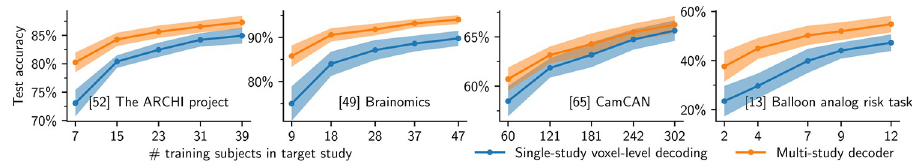
Fig 3. Varying accuracy improvement with study size. Training an MSTON decoder increases decoding accuracy for many studies (see Fig 2A). Gains are higher as we reduce the number of training subjects in target studies—pooling multiple studies is especially useful to decode studies performed on small cohorts. Error bars are calculated over 20 random data